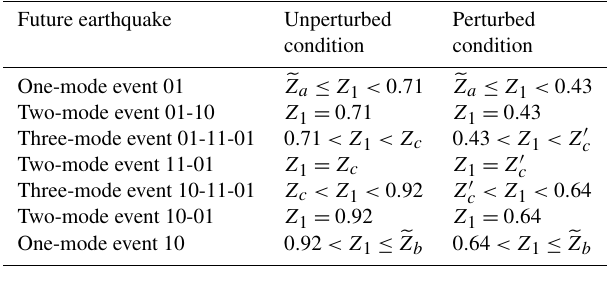
Table 3. Future earthquakes generated by the 1992 Landers, Cal- ifornia, fault, as functions of the variable Z 1 describing the initial state of the 1992 event, with Z 1 ∈ [ e Z a , e Z b ] = [− 1 . 16 , 2 . 19 ] . The results predicted by the model before and after the stress perturba- tion associated with the 1999 Hector Mine, California, earthquake are shown. The values Z 1 = Z c = 0 . 78 and Z 1 = Z (cid:48) c = 0 . 50 corre- spond to the largest possible earthquakes before and after the stress perturbation, respectively.